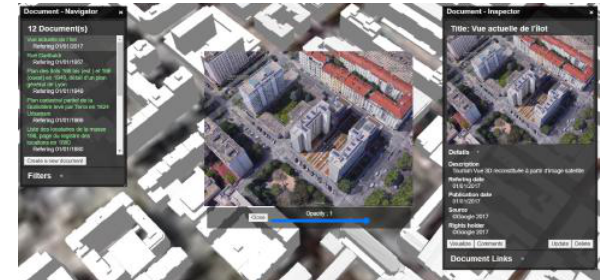
Figure 4. An example extended document with its three windows: the navigator window showing the list of available documents (left); the inspector window showing the metadata of the selected document (right); the visualization window that superimposes the document on the 3D scene (middle). Figure 3. An example of the 3D geo-web renderer approach. An html page is shown over the 3D scene.